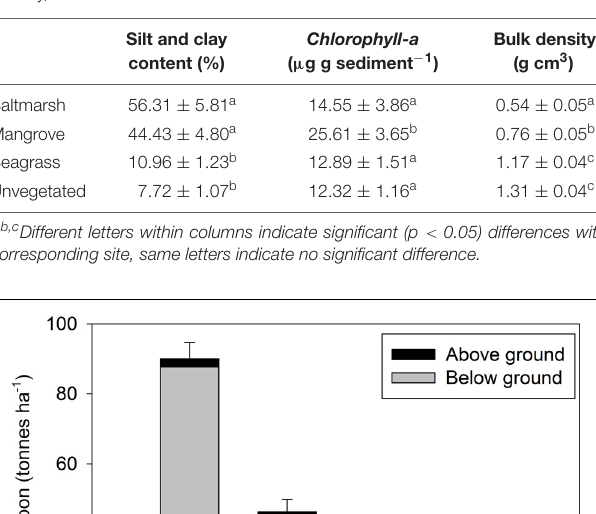
TABLE 1 | Mean sediment characteristics for estuarine habitats within Tairua estuary, ±